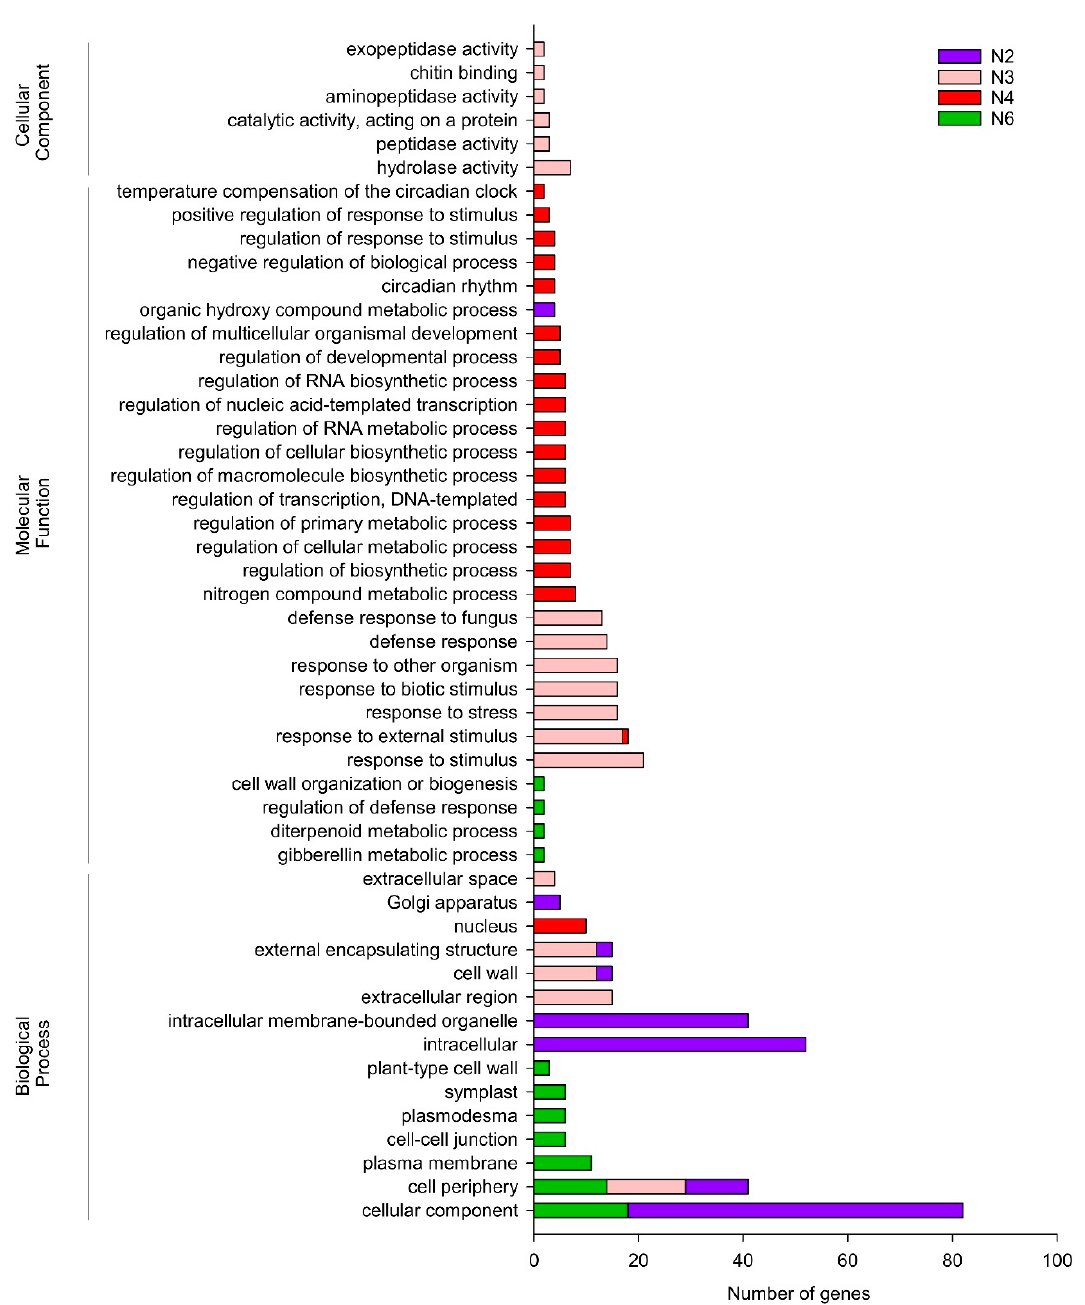
four most informative nodes (N) from SOM analysis. Gene function and relative gene enrichment